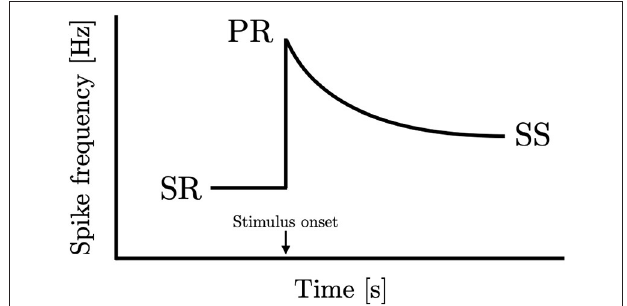
FIGURE 1 | Peripheral sensory adaptation curve. An idealized sensory adaptation response showing steady-state spontaneous rate (SR) prior to introduction of stimulus, the peak response to the stimulus (PR), and the subsequent new steady-state response